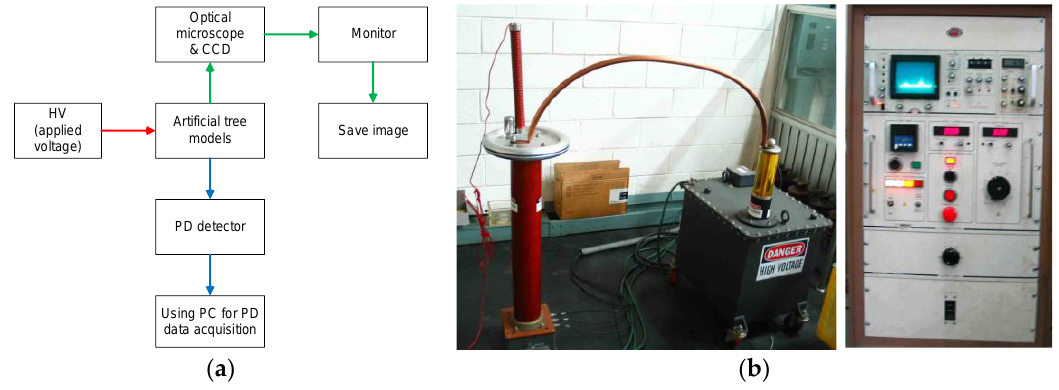
Figure 2. This is the test process of the experimental setup to detect the partial discharge (PD): ( a ) test process; ( b ) Partial discharge detector system.